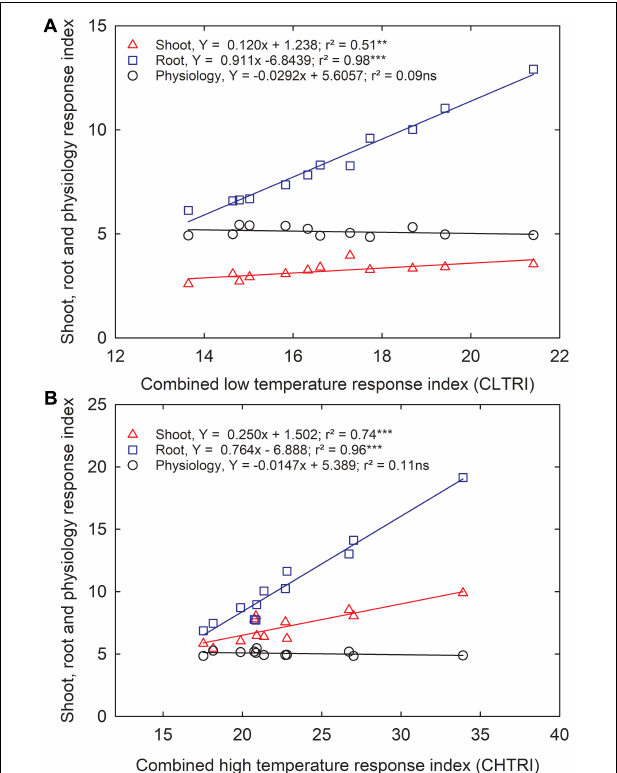
FIGURE 5 | The relationship between shoot, root, and physiological response index and cumulative low-temperature response index (CLTRI, A ) or cumulative high-temperature response index (CHTRI, B ) of 12 advanced Brassica carinata genotypes was measured 35 days after planting or 24 days after temperature treatments. Significance level: ** p < 0.01, *** p < 0.001; ns,